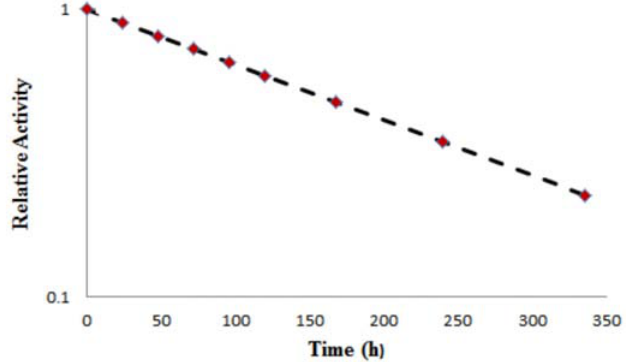
FIGURE 2 - Gamma-ray spectrum for 177 LuCl in this study. FIGURE 3- Decay scheme for 177 Lu used in this study.